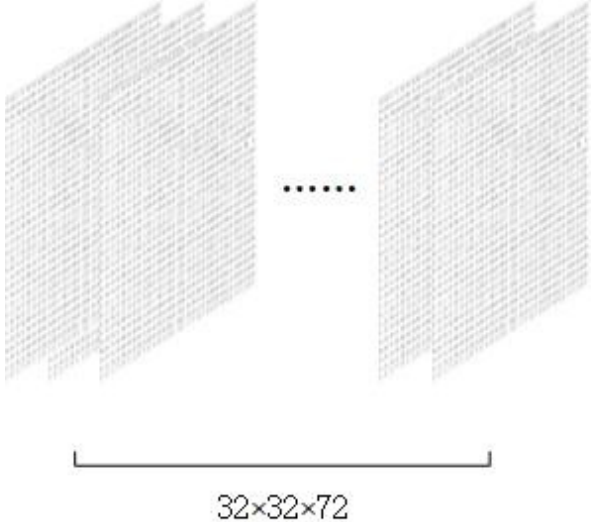
Figure 5. The preprocessing data. The dimension of 32 × 32 × 72 represents the size of the data in each dimension. Additionally, 32 × 32 is the size of a single sheet of data in space after cutting data. In addition, 72 represents the number of combinations of data recorded from different observation angles at different bands. The data we used had 8 bands and 9 observation angles, so there were 72 combinations.